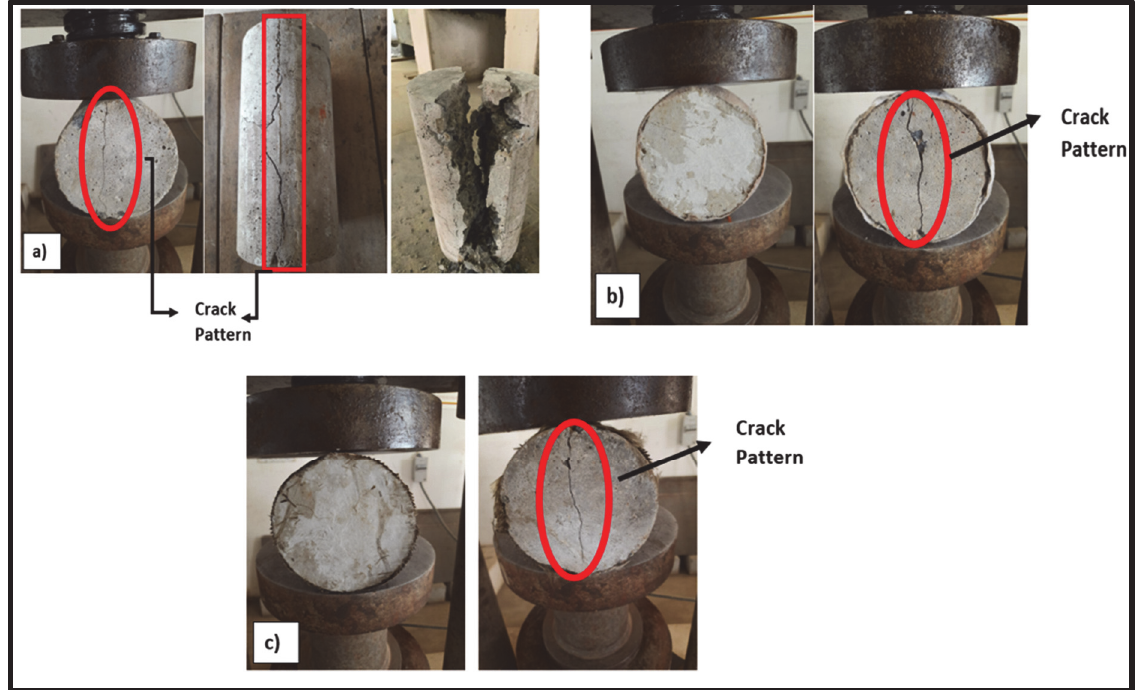
Figure 6: Cracked samples under split Tensile Test (a) pristine concrete (b) Geo-Textile wrapped concrete and (c) Basalt fiber wrapped